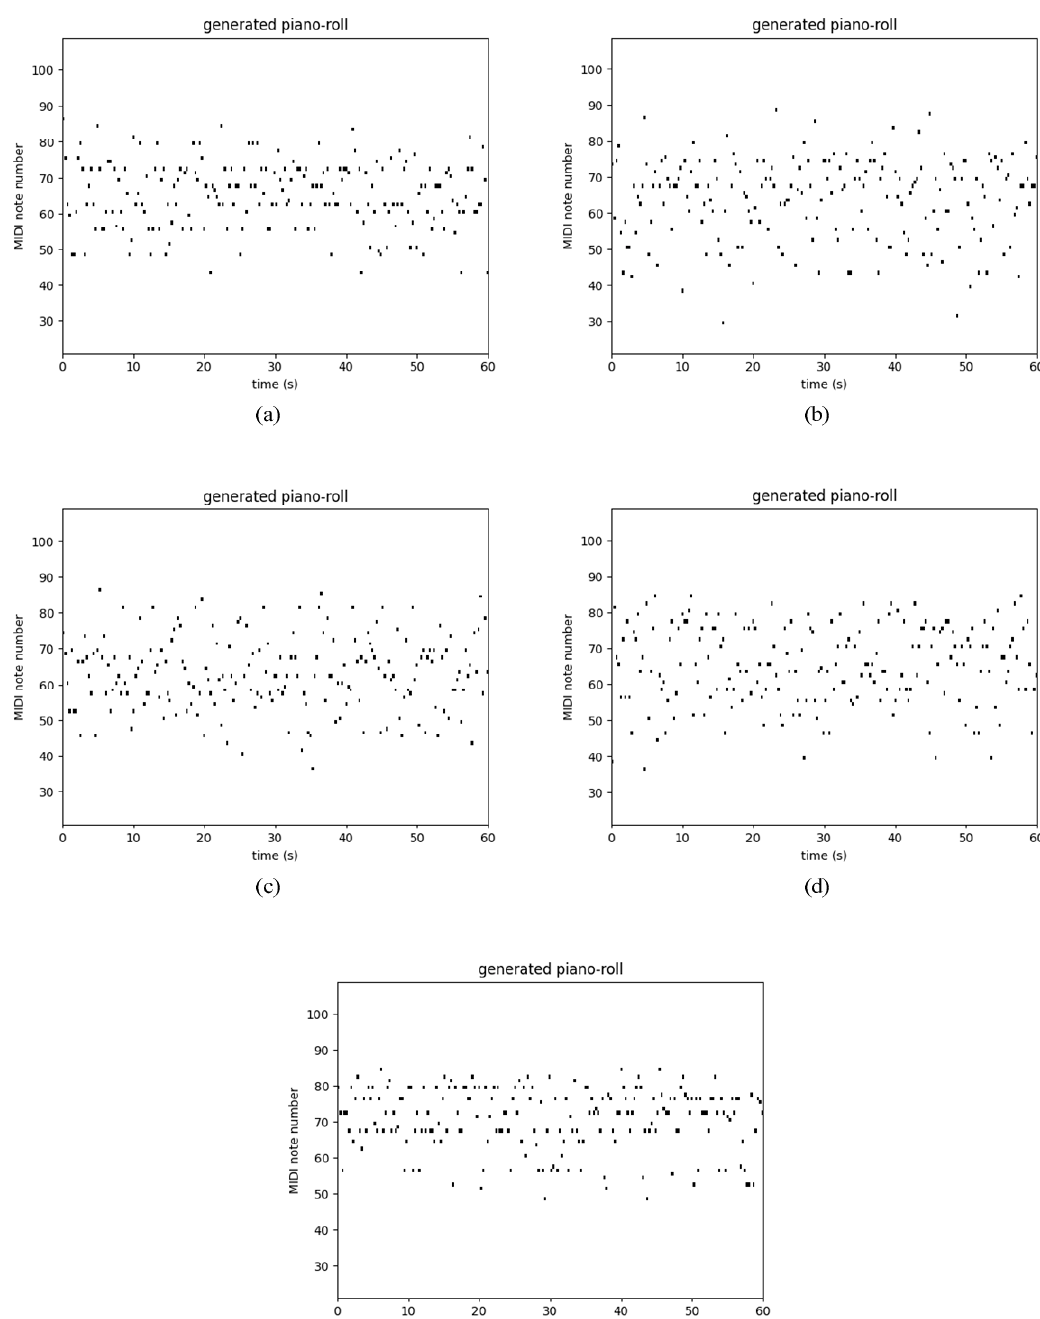
Figure 8. Sample of polyphonic music generation by the ( a ) RNN [9], ( b ) LSTM [16] and ( c ) GRU [17], ( d ) Res-RNN and ( e ) Res-RNN with gates trained with the databases of Muse Data.